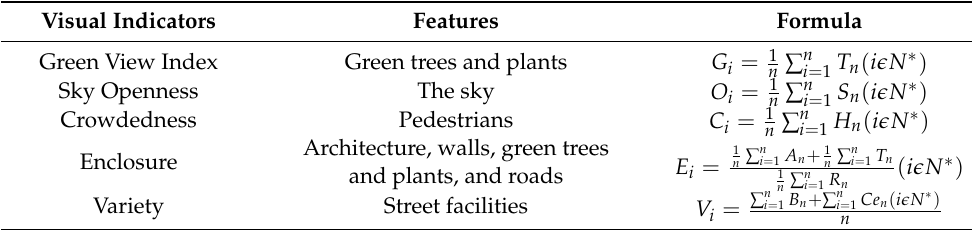
Table 1. Visual indicators and features of street space in Gulangyu. Visual